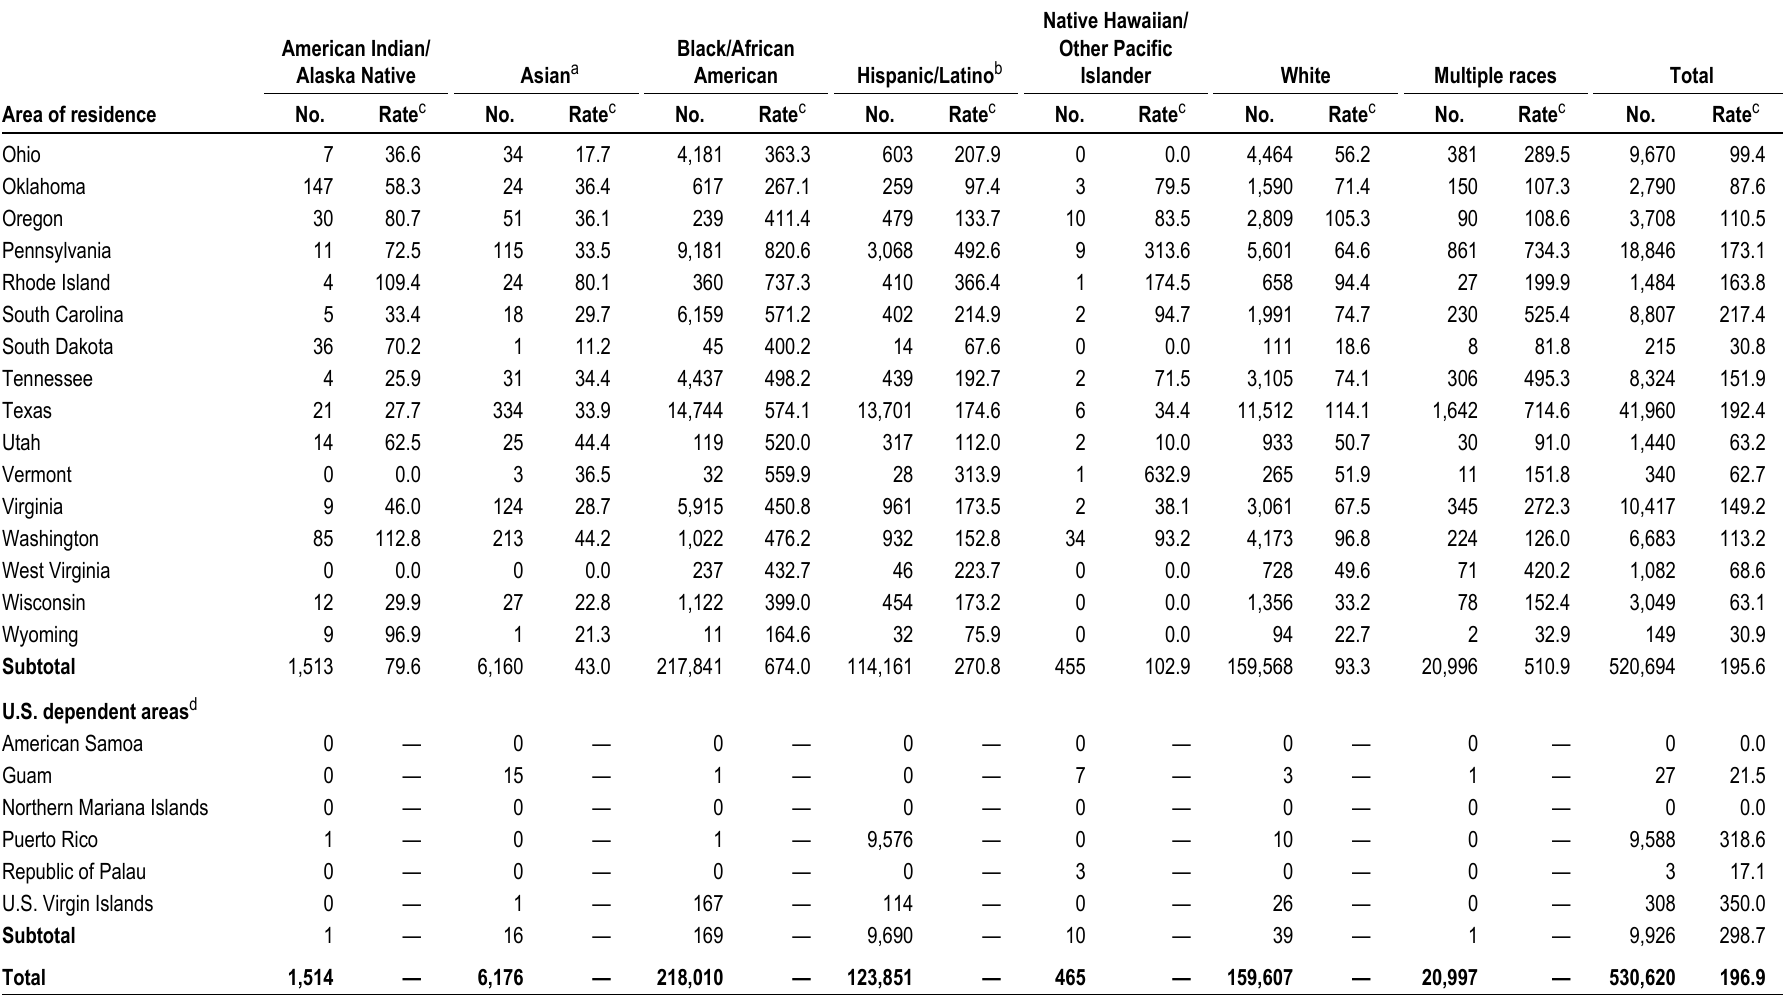
Table 25. Adults and adolescents living with diagnosed HIV infection ever classified as stage 3 (AIDS), by race/ethnicity and area of residence, year-end 2014—United States and 6 dependent areas